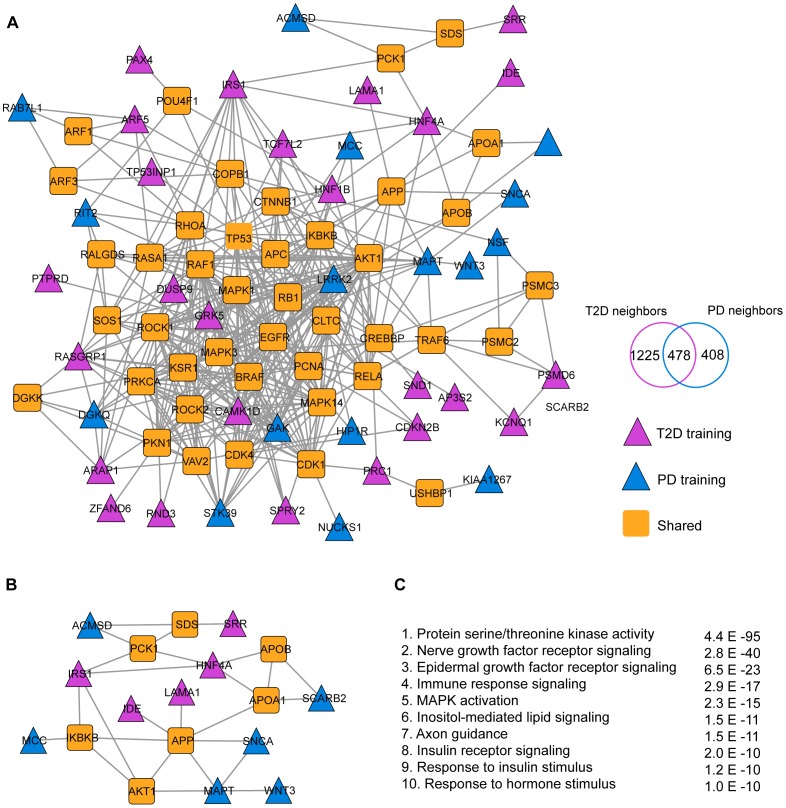
Functional linkage network for Parkinson's disease and type 2 diabetes.
A. Network visualization of the top 200 shared genes (orange rectangles) closely associated with training genes associated with Parkinson's disease training genes (blue triangles) and type 2 diabetes (purple triangles) within the FLN (displayed in gray). Venn diagram analysis of shared neighboring genes in Parkinson's disease and type 2 diabetes. B. Subnetwork visualization of interactions among confirmed Parkinson's disease and type 2 diabetes genes with APP. C. Overrepresented pathways identified in Parkinson's disease and type 2 diabetes, as retrieved by Genemania. PD  =  Parkinson's disease, IFG  =  pre-diabetes and T2D  =  type 2 diabetes.